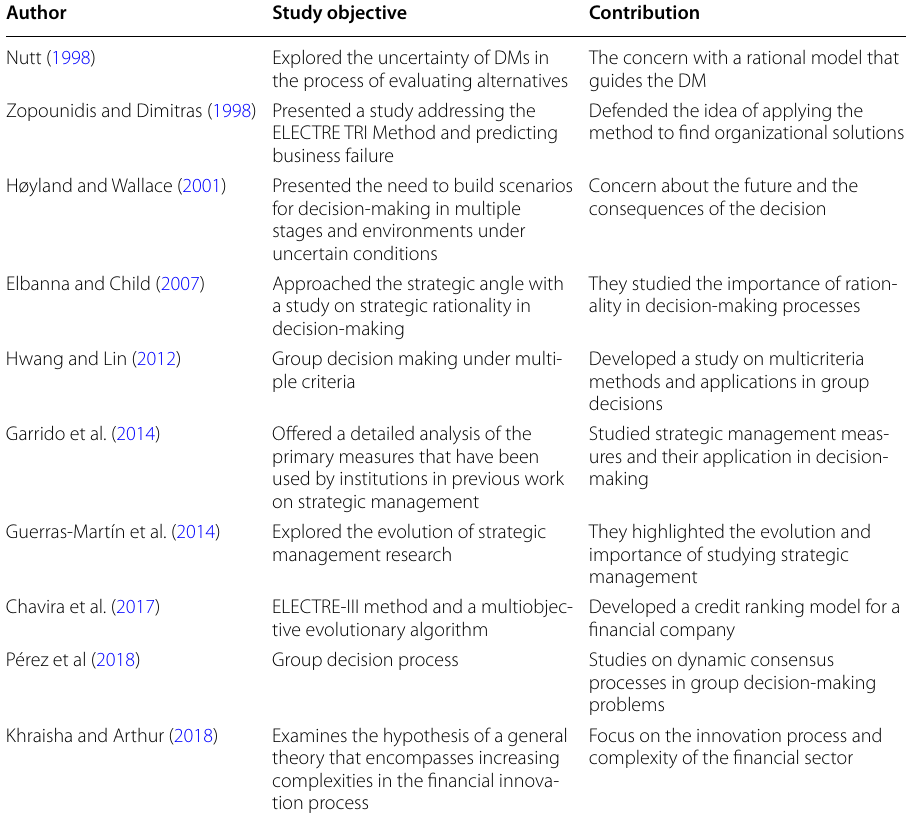
Table 1 Strategic concepts that guided the decision-making model Author Study